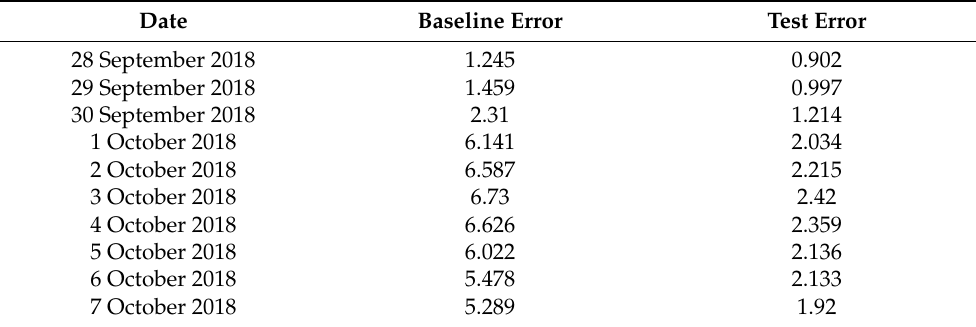
Table 4. Errors on the entire test set of the 18-parameter model by 10 min